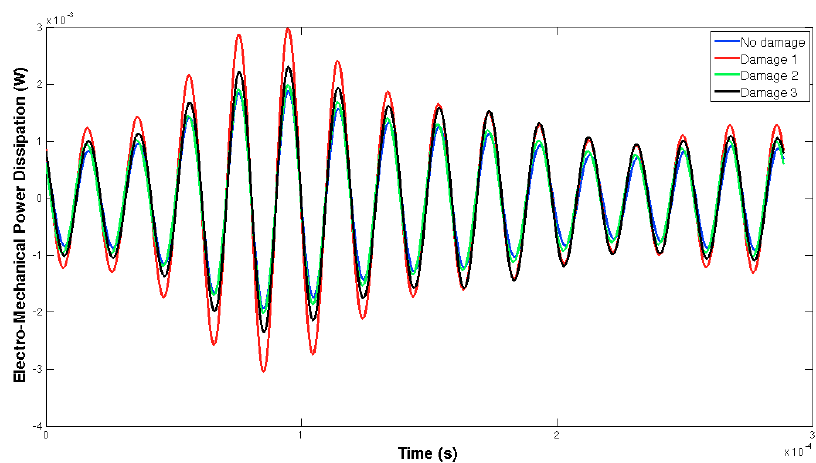
Figure 13. EMPD at 50 kHz. Tone-burst sent from sensor 1 to sensor 2.